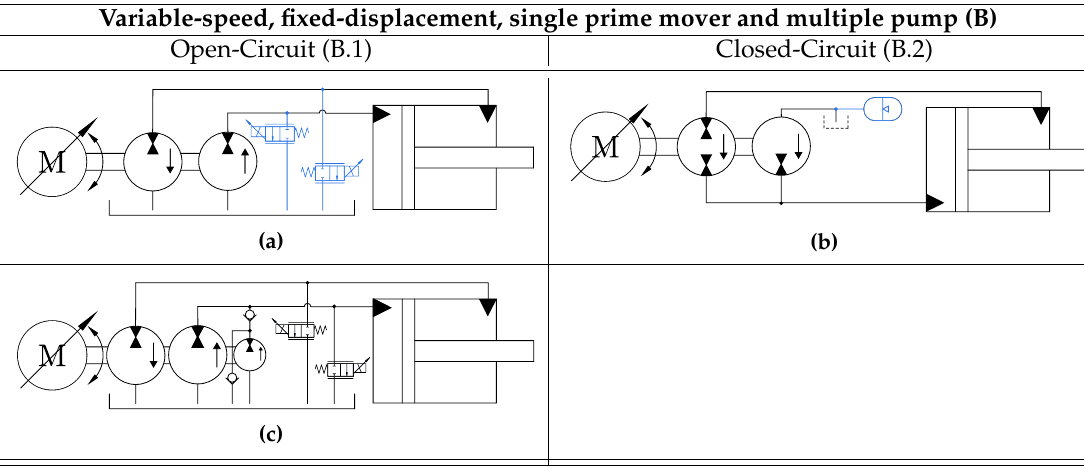
Figure 6. Overview of class B architectures (simplified schematics). The arrow inside the pump symbols denote main flow direction for positive shaft speeds. Blue components indicate that these components are only included by some researchers. ( a ) Two pump architecture in open-circuit configuration; ( b ) Two pump architecture in closed-circuit configuration; ( c ) Architecture based on three pumps in open-circuit